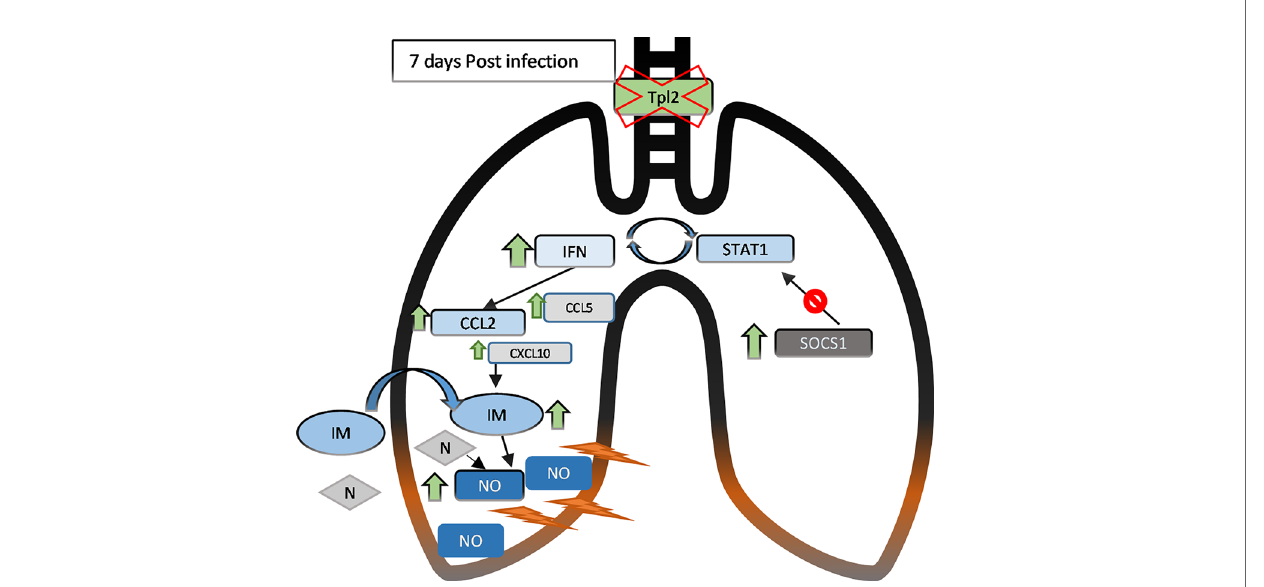
FIGURE 7 | In the lungs of in fl uenza-infected Tpl2 -/- mice at 7 dpi, upregulation (green arrows) of the IFNs and chemokines leads to recruitment and retention of in fl ammatory monocytes (IM, ovals) and neutrophils (N, diamonds) that lead to lung damage likely via nitric oxide (NO). IFN signaling also activates the SOCS1 transcriptional repressor, that suppresses STAT1 mRNA levels to limit further IFN signaling by 9 dpi. However, inef fi cient SOCS1-mediated repression in Tpl2 -/- mice allows persistent CCL2 overexpression and in fl ammation, progressing to morbidity and